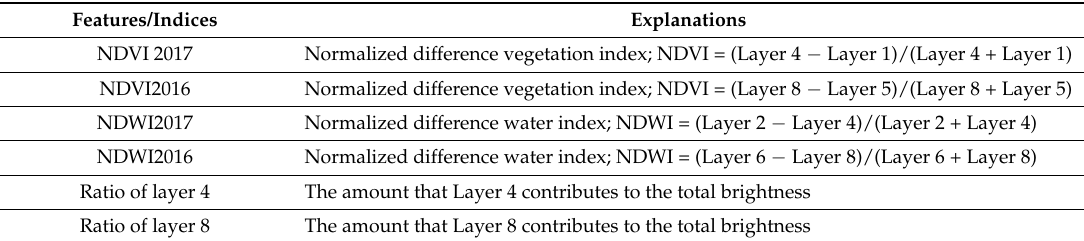
Table 4. Features and indices used in this